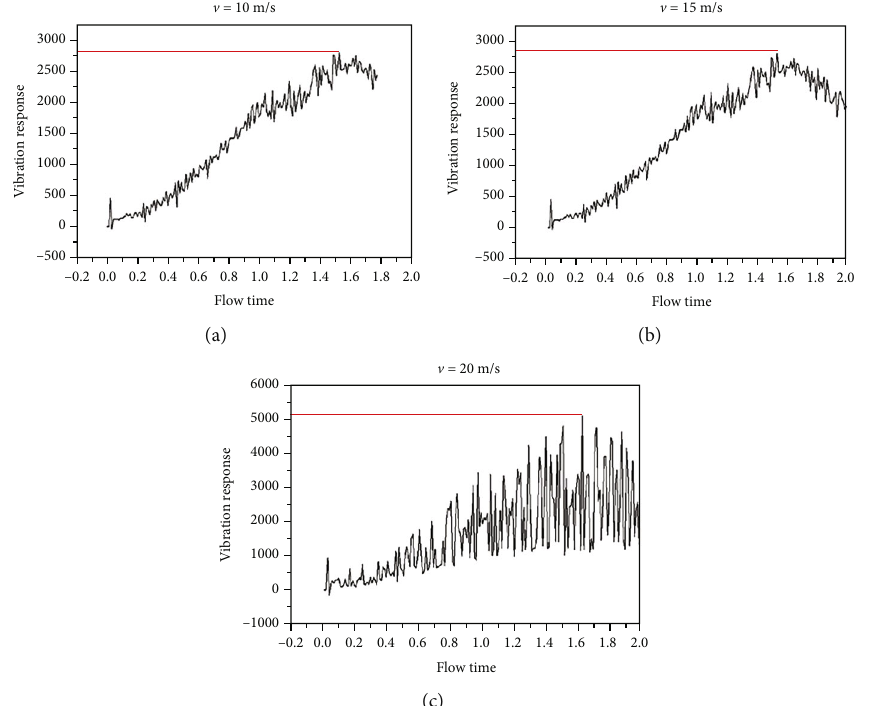
Figure 7: Wind-induced vibration responses of the arch roof at di ff erent wind speeds, v = 10 m/s (a), v = 15 m/s (b), and v = 20 m/s (c). The red line indicates the maximum vibration response value.